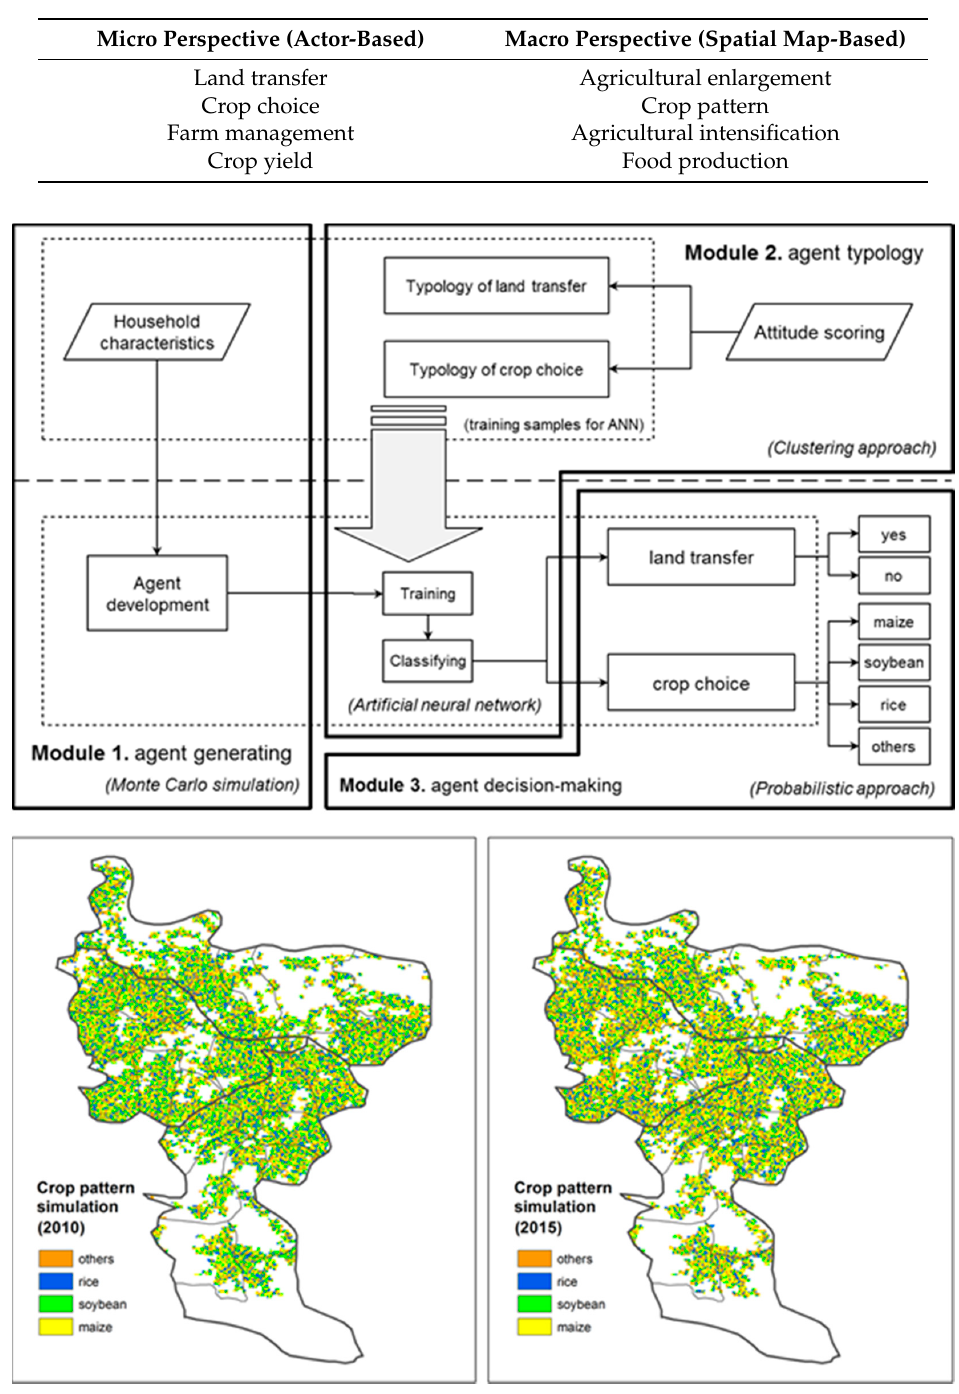
Figure 7. Application of the CroPaDy model based on the human–land integrated information.